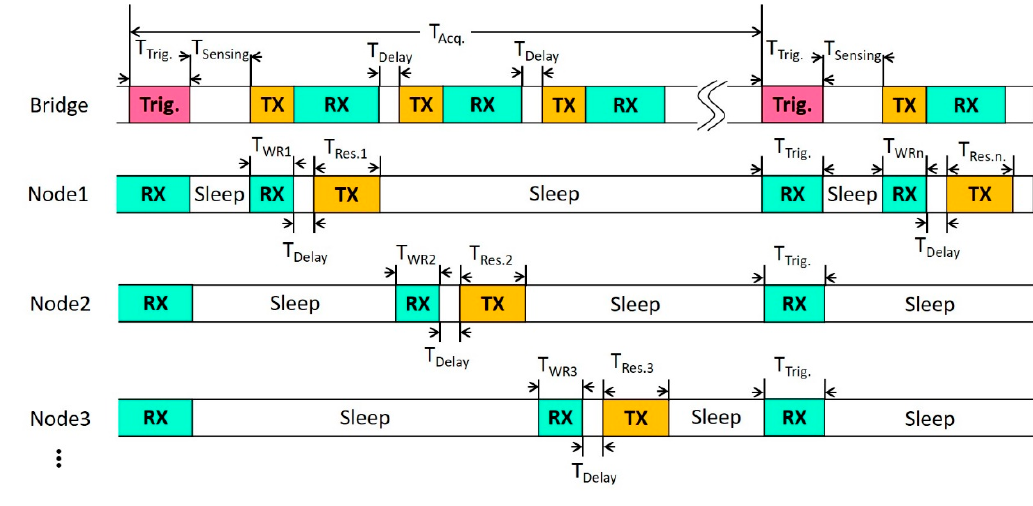
( b ) Figure 3. ( a ) The placement of the bridge; ( b ) the placement of node 2 and node 7. 3.2. TDMA Protocol Figure 4 is a TDMA diagram proposed in this paper. The concept is to predetermine the